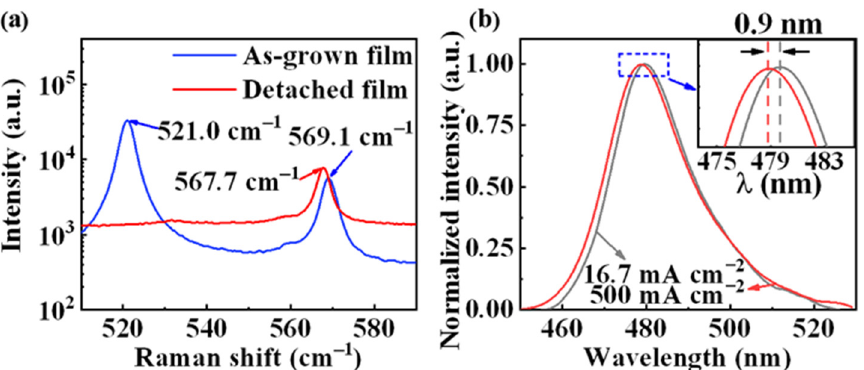
Figure 2. ( a ) Raman spectra of the detached and as-grown films. ( b ) EL spectra of the monolithic device based on the detached film when injecting the current.